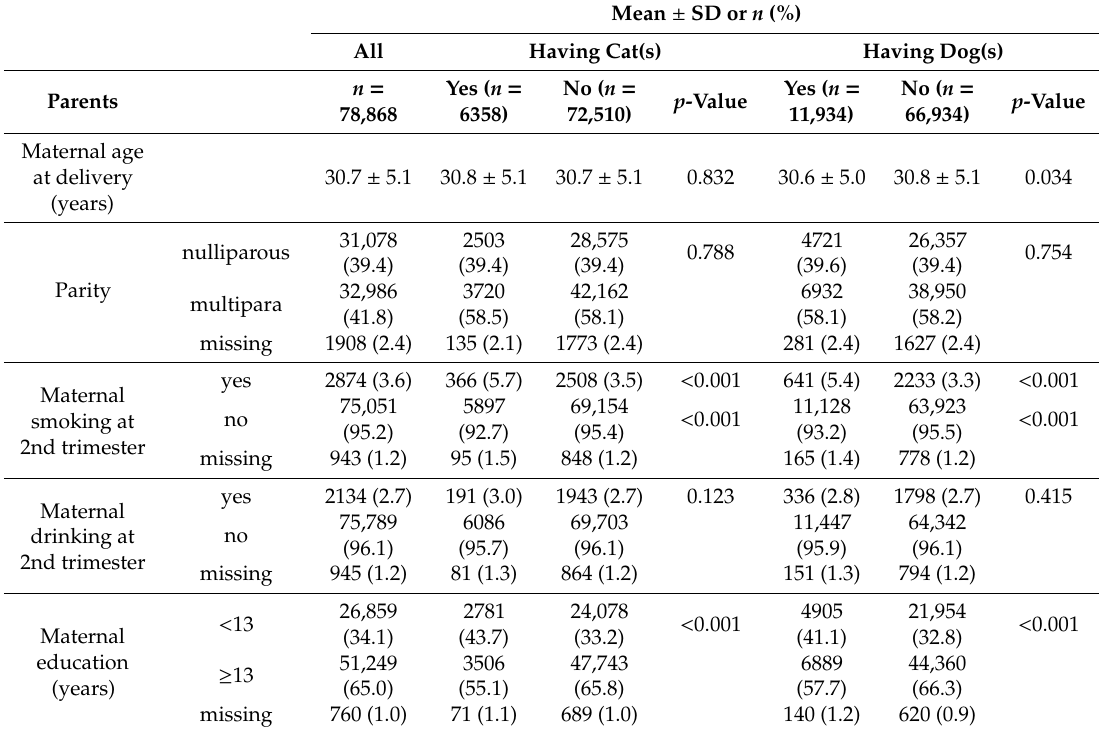
Table 1. Characteristics of